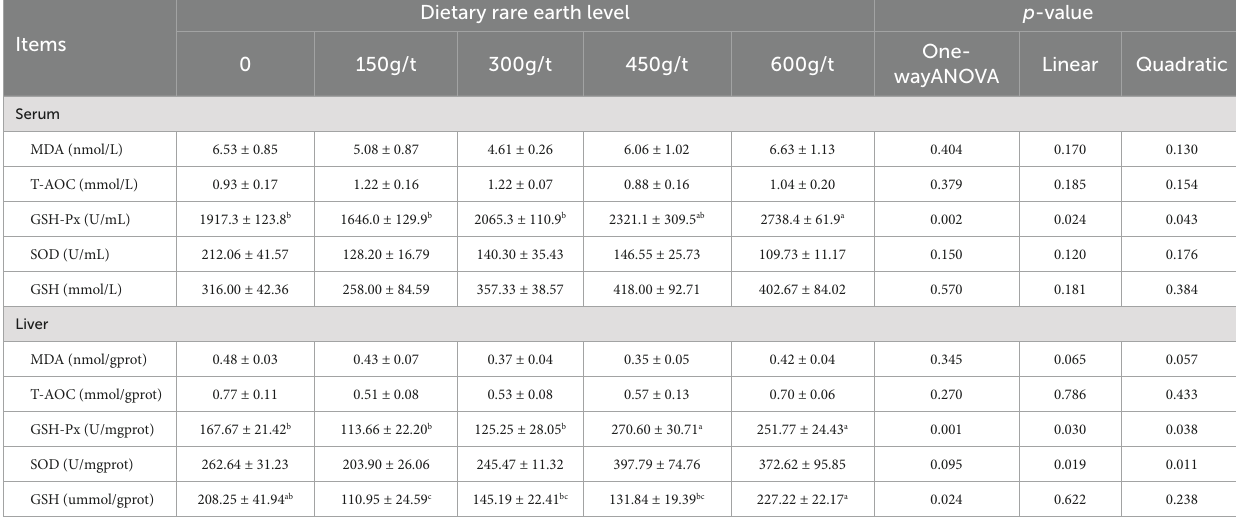
TABLE 5 Effects of dietary rare earth supplementation on the antioxidant index in the serum and liver of laying hens during the late laying stage ( n = 6).